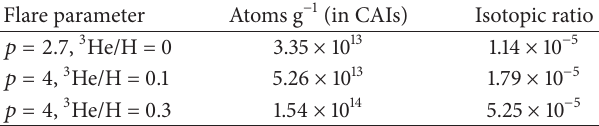
Table 3: Predicted 36 Cl content in CAIs. Flare parameter Atoms g − 1 (in CAIs)